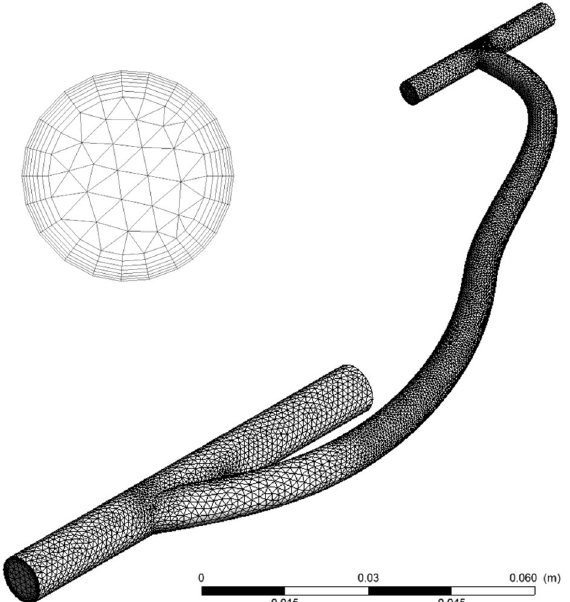
Figure 2. The mesh of the idealized arteriovenous model. The smaller diameter cylinder represents the artery, and the larger diameter cylinder represents the vein. The two were connected by an arteriovenous graft. Shown is a model with a 30° graft-to-vein anastomosis angle. The inset is a close up of the venous outlet that provides a representation of the mesh refinement at the boundary layer. The maximum aspect ratio of the boundary layer elements was 10:1. In all simulations, the vein length was 72 mm, with the length distal to the graft held at 25 mm and the length proximal to the graft ranging from 40 mm to 17 mm depending on the anastomosis